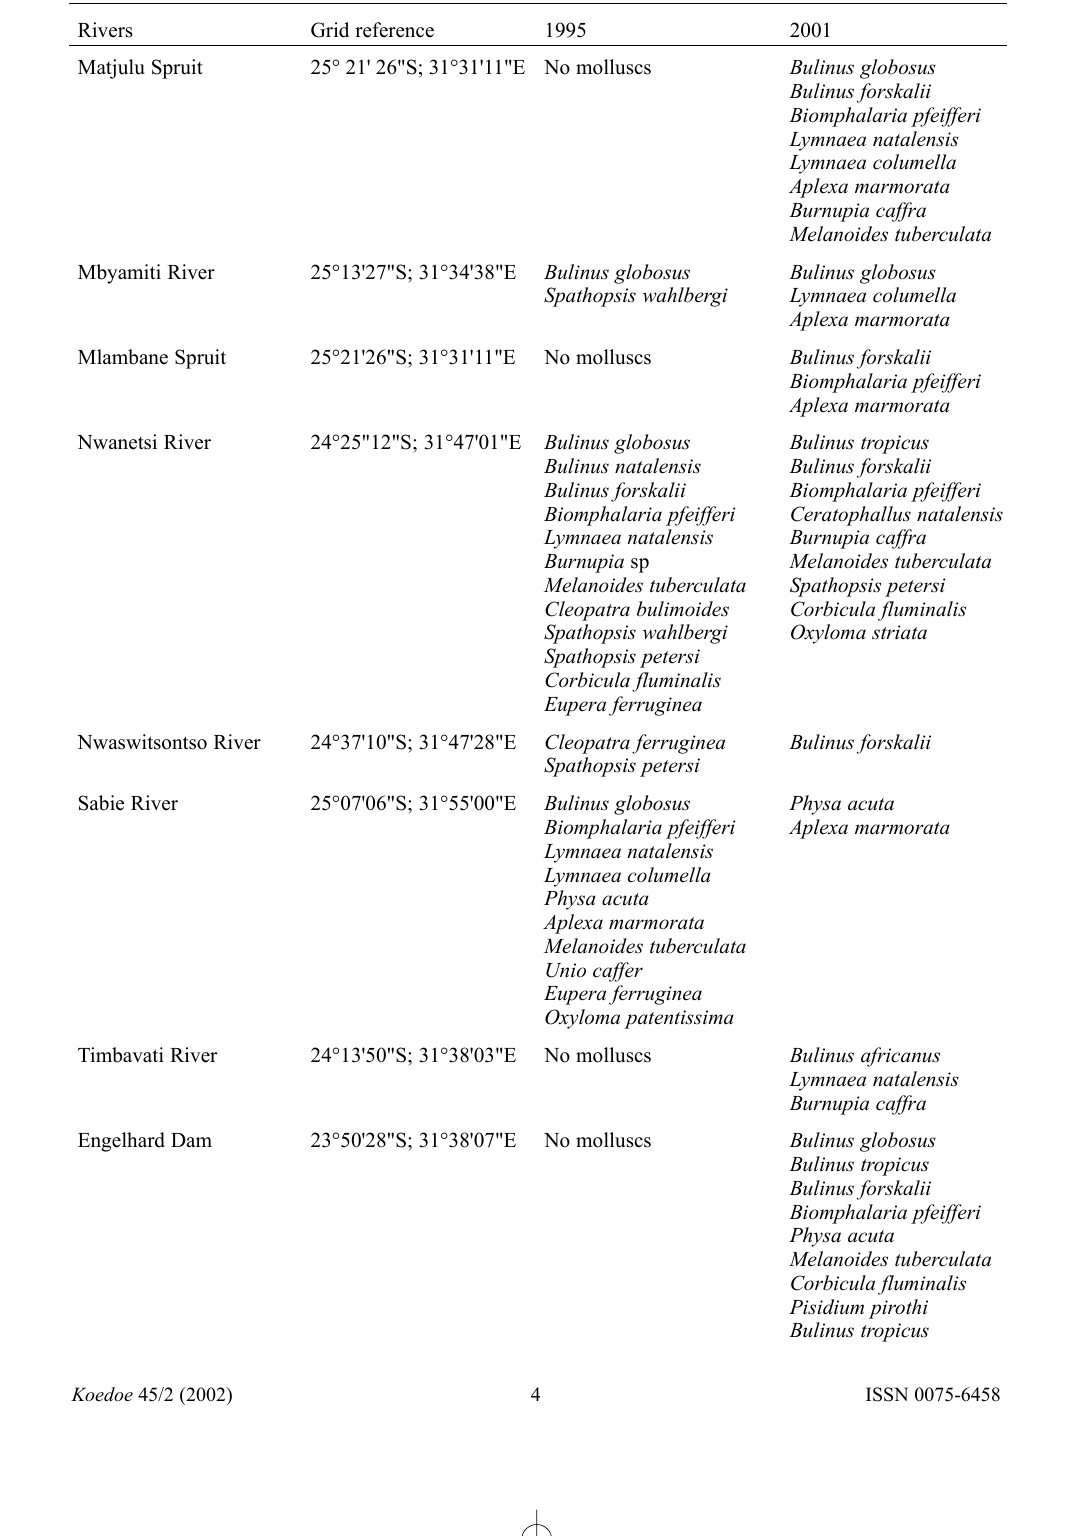
Habitats of the Kruger National Park surveyed in both 1995 and